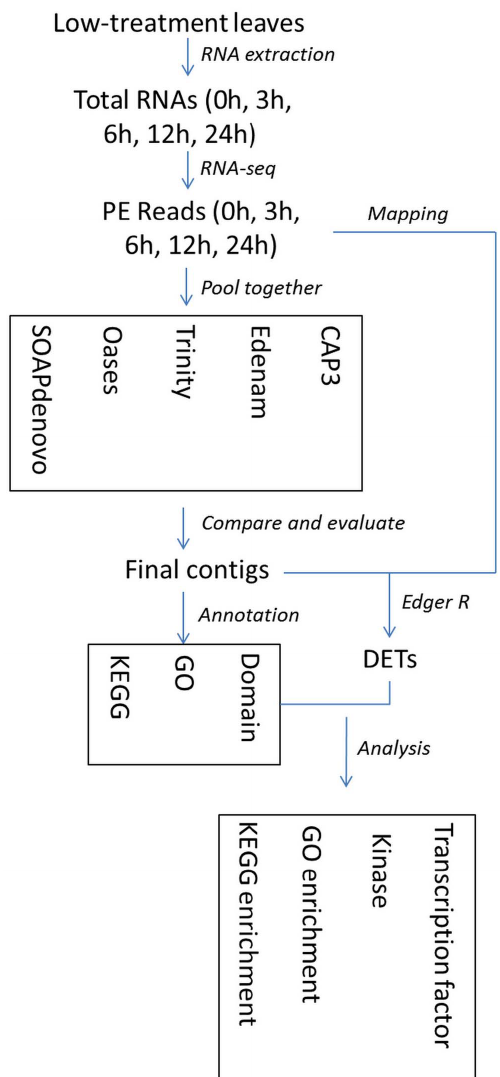
Figure 2. The pipeline for the bioinformatics analysis of the deep sequencing data.